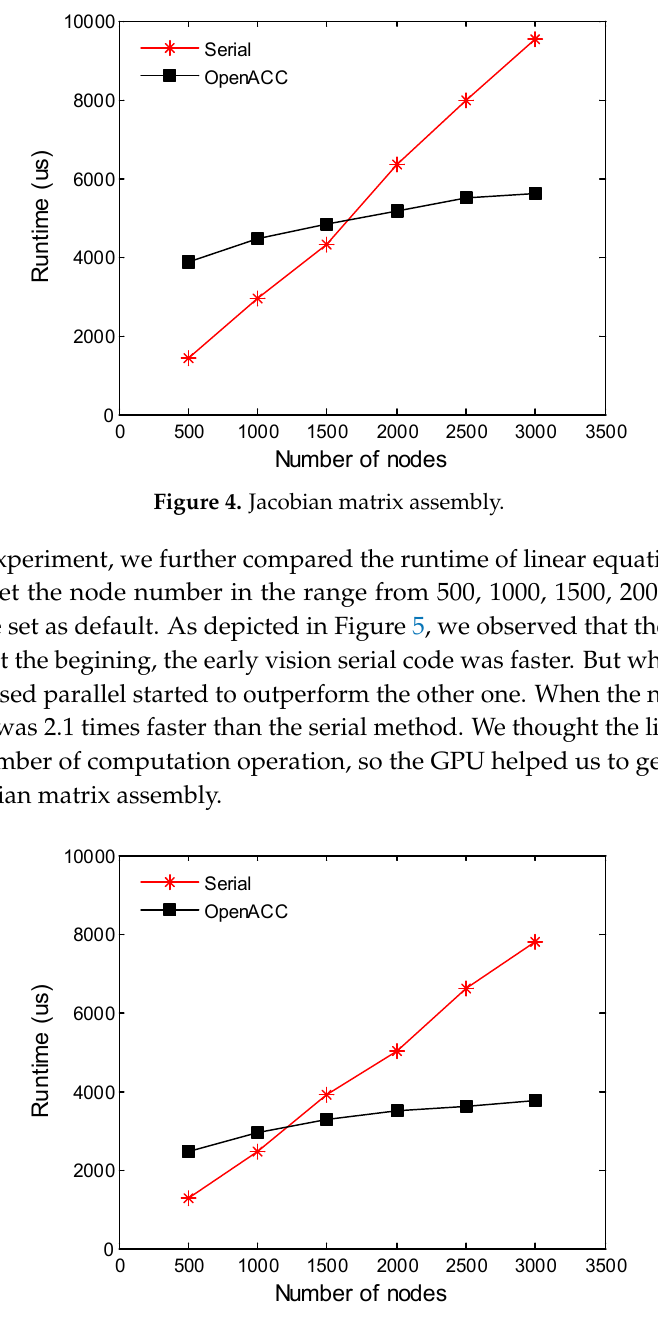
Figure 5. Linear equations